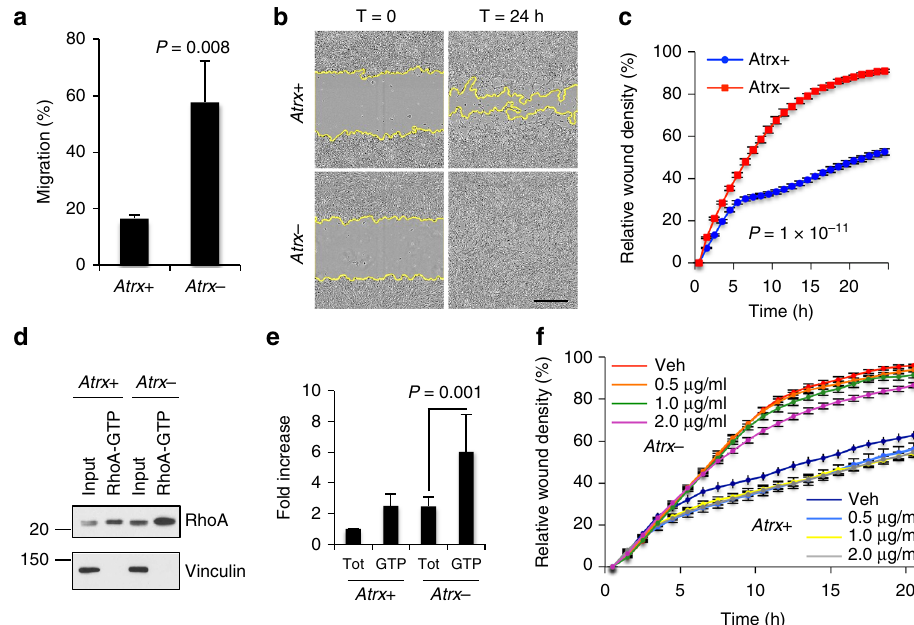
Fig. 3 Atrx de fi ciency promotes mNPC motility. Transwell ( a; 5 replicates) and wound healing ( b , c; 3 replicates) assays showing increased migratory behavior in Atrx- mNPCs (scale bar 300 µ m). This phenotype was accompanied by increased GTP-bound RhoA by IP western analysis ( d ) with quantitation by densitometry ( e; average of 3 biological replicates, Vinculin loading control). f wound healing assay for Atrx + and Atrx - NPCs treated with the RhoA inhibitor C3 exoenzyme at the designated levels (3 replicates; Atrx -: Veh vs 0.5 μ g/ml — P = 0.034, Veh vs 1 μ g/ml — P = 9.8 × 10 -6 , Veh vs 2 μ g/ml — P = 5.5× 10 -5 ; Atrx + : Veh vs 0.5 μ g/ml — P = 8.5 × 10 − 11 , Veh vs 1 μ g/ml — P = 2.7 × 10 − 9 , Veh vs 2 μ g/ml — P = 1.4 × 10 − 9 ). P values determined by unpaired two-tailed t-test for both transwell assays and western blot densitometry, and by paired two-tailed t-test at all time points for wound healing